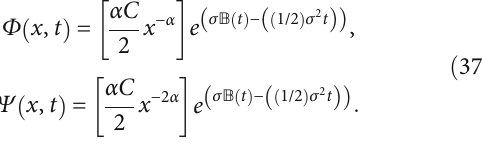
ffiffiffiffiffiffiffiffiffiffiffiffiffi − q /2 ð